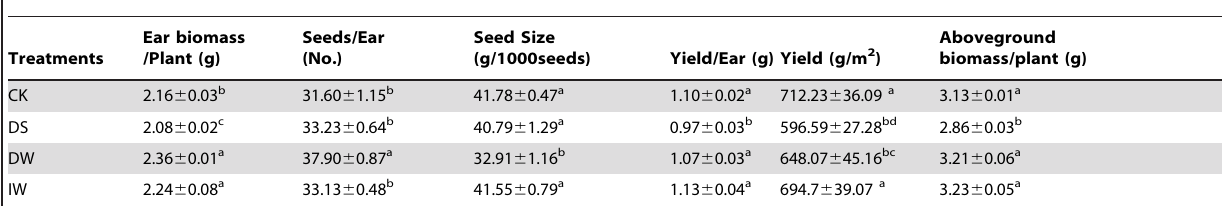
Table 1. Yield and yield attributes for a winter wheat, Triticum aestivum cv. super-626, to different treatments, i.e. control (CK), delay sowing date as well as warming (DS), warming both day and night (DW), increase water addition as well as warming (IW). Mean ( 6 SEM). n